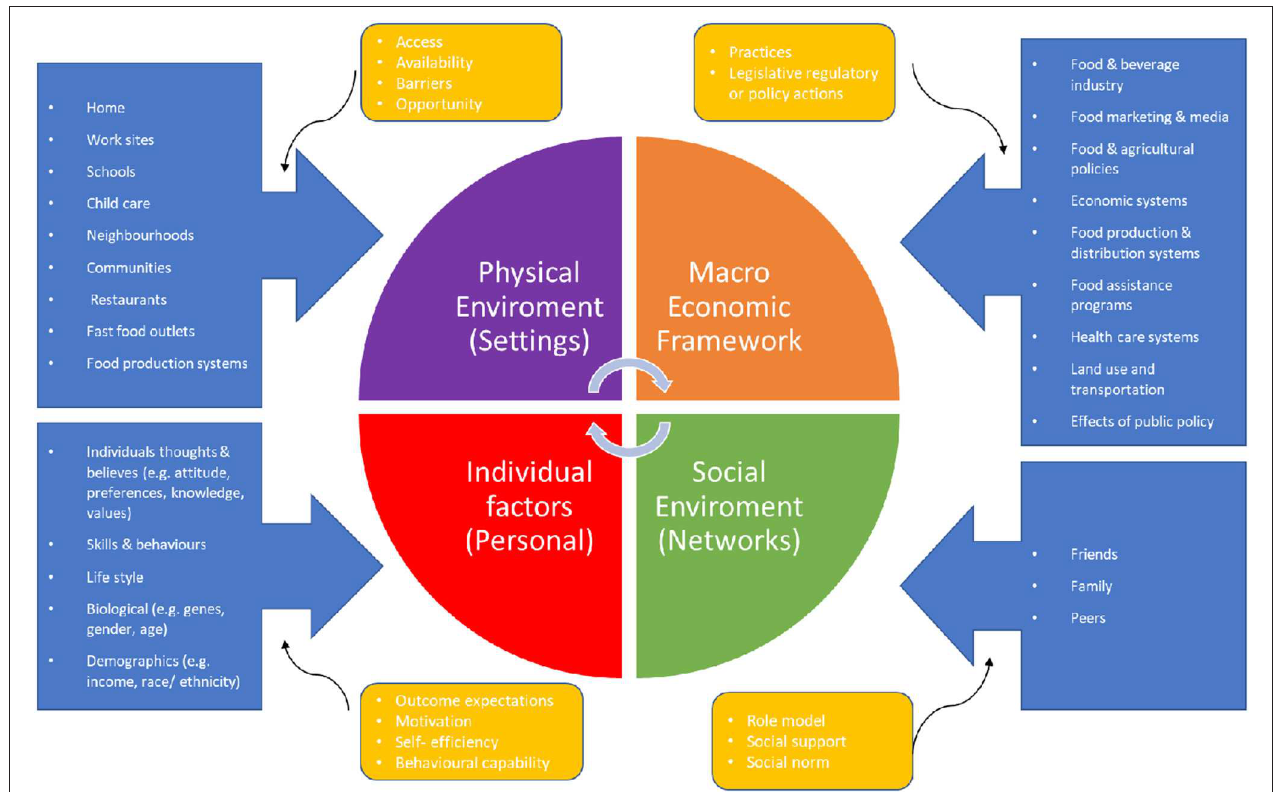
FIGURE 1 | A systematic representation of the four determinants that affect an individual’s eating